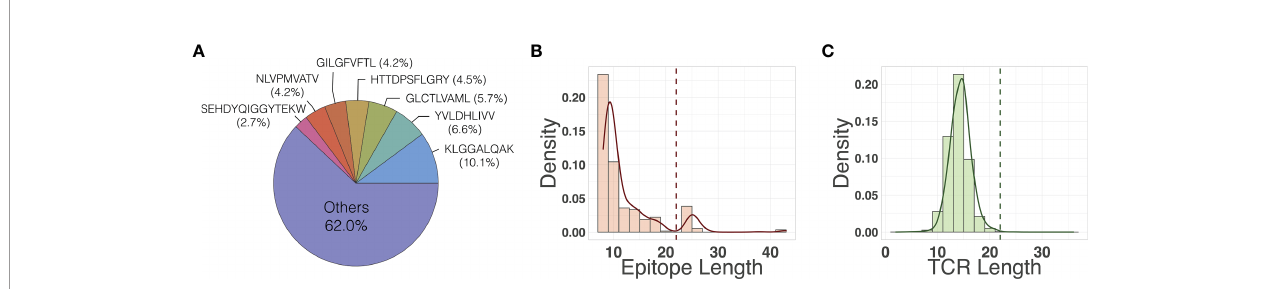
FIGURE 3 | (A) Frequency of epitopes in the primary dataset. Distribution of (B) epitope length and (C) TCR length in the primary dataset. Dashed vertical lines indicate the maximum input sequence length hyperparameters chose by our